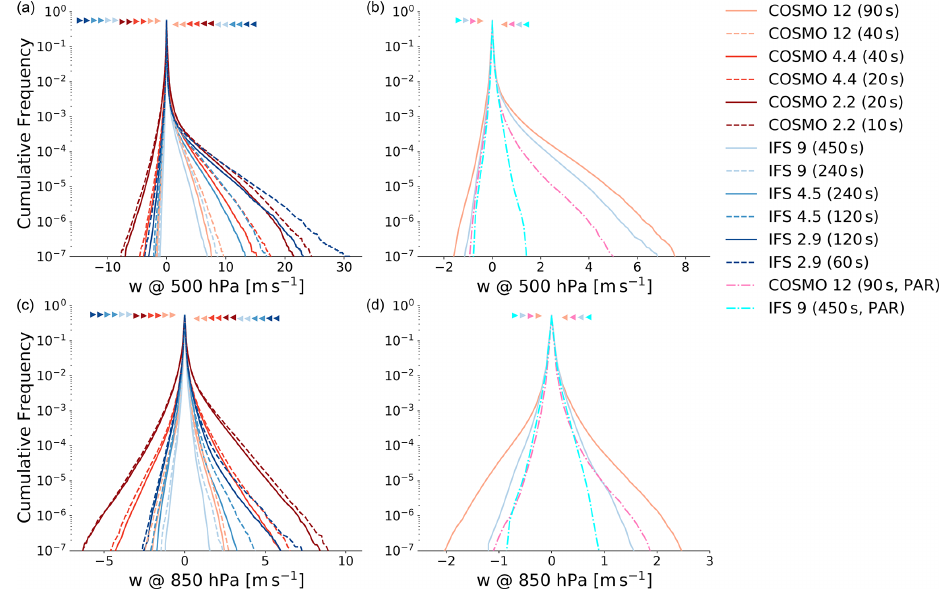
Figure 6. Cumulative frequency of vertical wind velocity on the 500hPa (upper row) and 850hPa pressure levels (lower row) with the same layout as in Fig. 3. The triangles indicate the height of the respective starting points, that is, the frequency of downdrafts ( < 0ms − 1 ) and updrafts ( > 0ms − 1 ). Note the different scales on the horizontal axes.